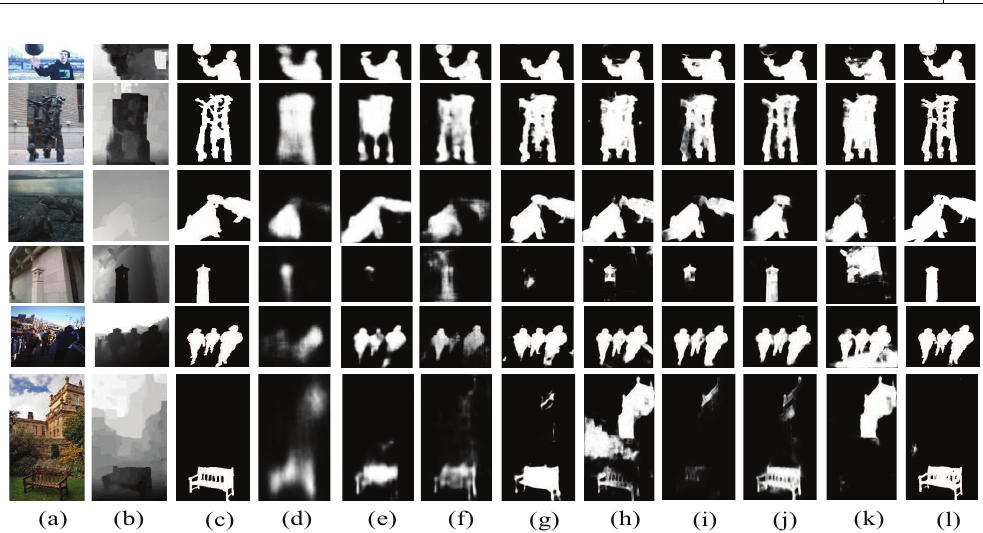
Figure 7. Visual comparison of different RGB-D SOD methods. Annotations of from left to right are: ( a ) Input image, ( b ) depth, ( c ) Ground Truth, ( d ) DMRA [47], ( e ) TANet [11], ( f ) MMCI [15], ( g ) CPFP [12], ( h ) CMWN [14], ( i ) DANet [46], ( j ) D3Net [26], ( k ) ICNet [10], and ( l )